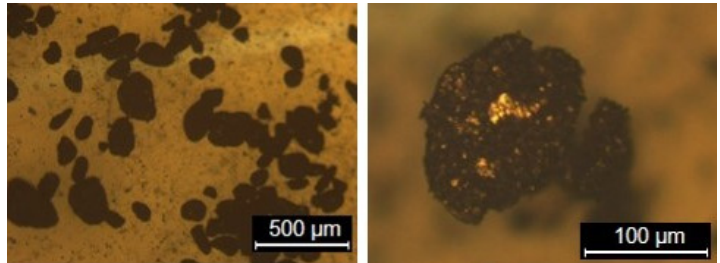
Figure 8. Micrographs of wear debris from dry sliding test at different magnifications.